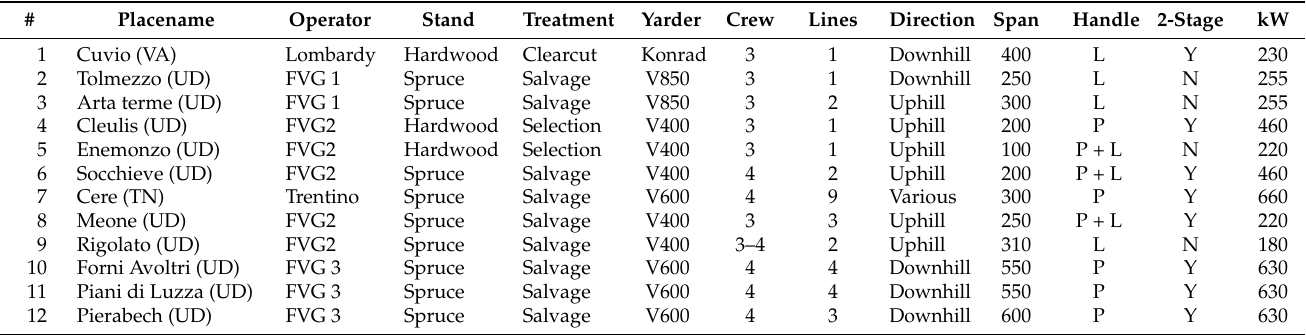
Table 1. Description of the test operations.